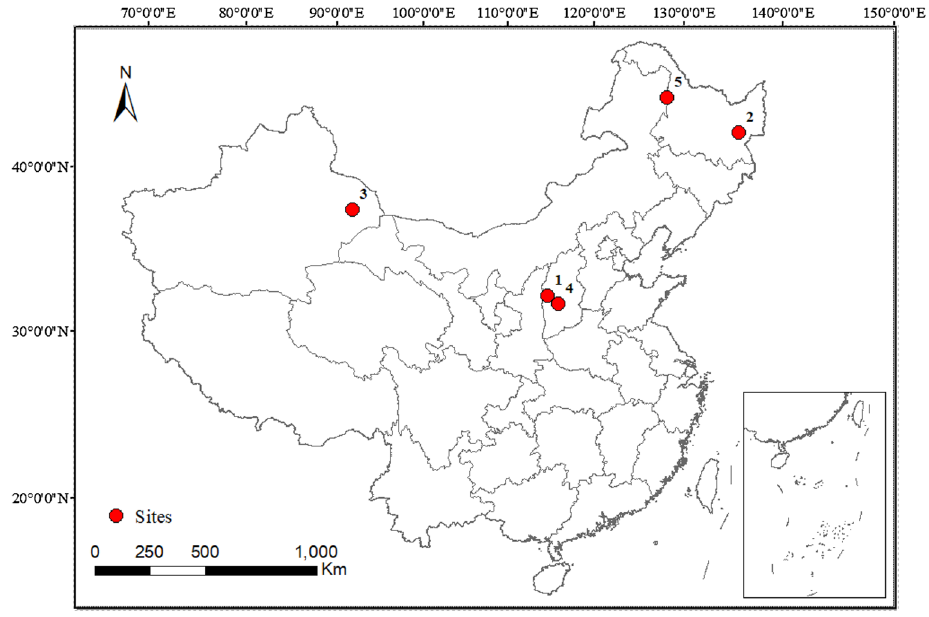
Figure 7. Sites location of the five collected coals, 1, Liulin; 2, Qitaihe; 3, Hami; 4, Lingshi; 5,